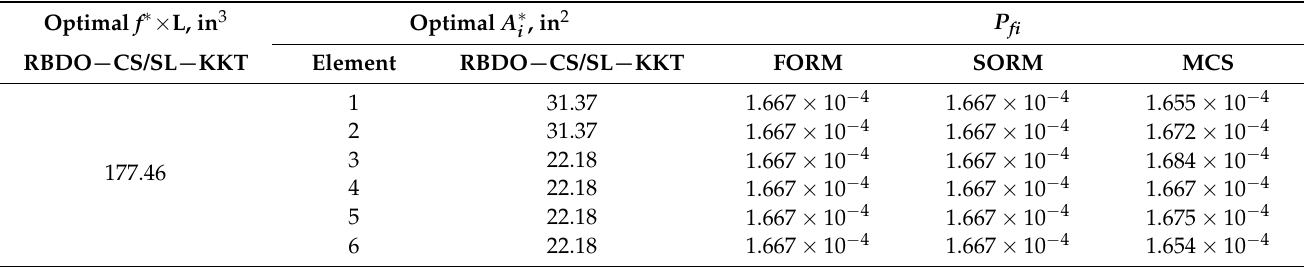
Table 9. Results of the RBDO − CS and SL − KKT approaches for the truss optimization problem.